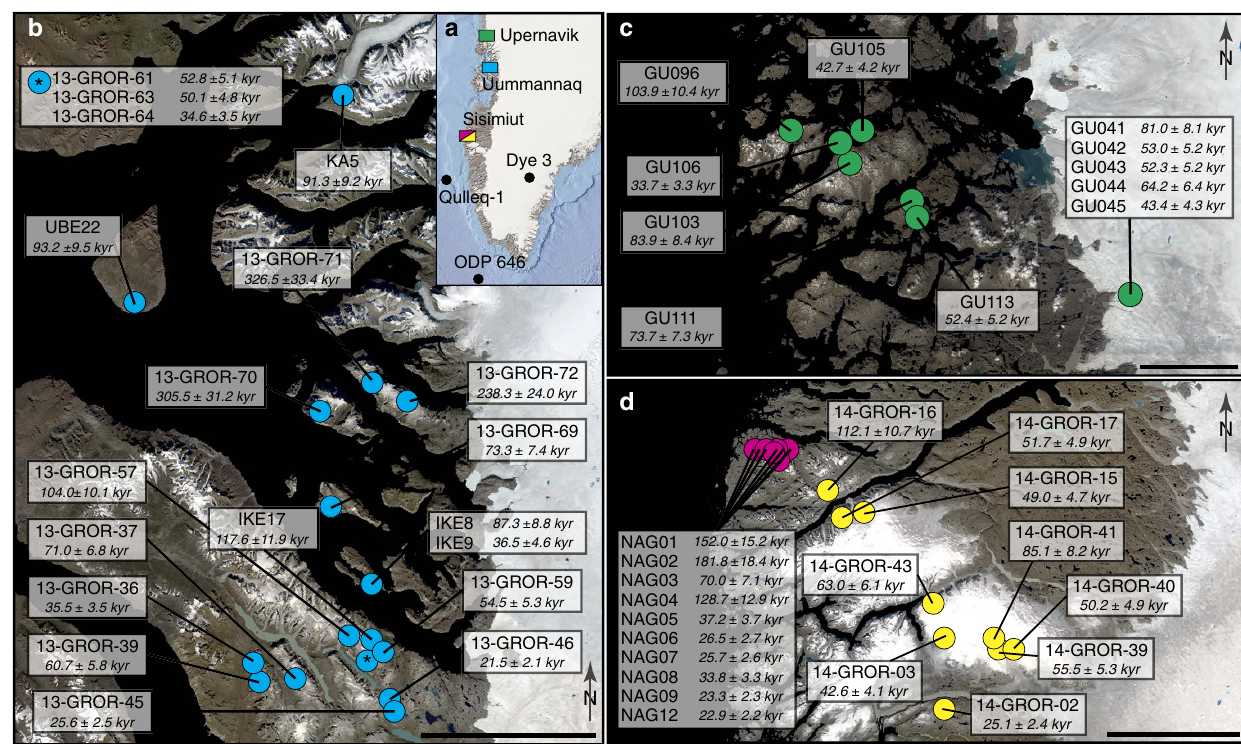
Figure 1 | Overview maps of sample sites and simple exposure 10 Be ages. ( a ) South Greenland overview with coloured boxes marking the four TCN sample sites and black circles marking points of pre-LGM Quaternary data 5,7,36 . ( b ) Uummannaq area with sample sites containing 10 Be and 26 Al bedrock data 19 . The point marked with an asterisk represents 3 sample sites, which are shown in the top left box. The scale bar is 50km wide. ( c ) Sample sites with 10 Be and 26 Al bedrock data 20,24,25 from the Upernavik area. The scale bar is 25km wide. ( d ) Sisimiut area, covering samples from two sites; the inter-fjord site Itilleq 26 (red) and samples from the margins of the local ice cap Sukkertoppen 20 (yellow). The scale bar is 50km wide. The data points shown in ( b – d ) meet the criteria of being applicable to the MCMC model approach, by having simple exposure 10 Be ages above 20kyr and a 26 Al/ 10 Be ratio below 7.5. ( b – d ) Simple exposure 10 Be ages are calculated using Cronus Version 2.3 (ref. 45) and the Lal (1991)/Stone (2000) scaling scheme 40,41 . Figure 1 was created using QGIS software 46 . All satellite images are from Landsat8, August 2016, courtesy of the U.S. Geological Survey. NATURE COMMUNICATIONS|8:14199|DOI: